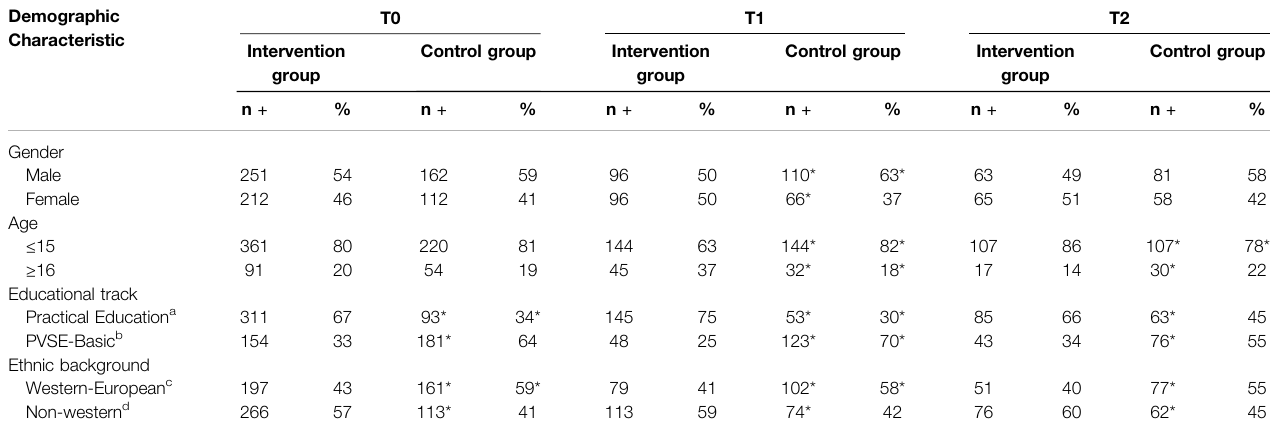
+ Due to missing values, actual numbers may vary * p < 0.05